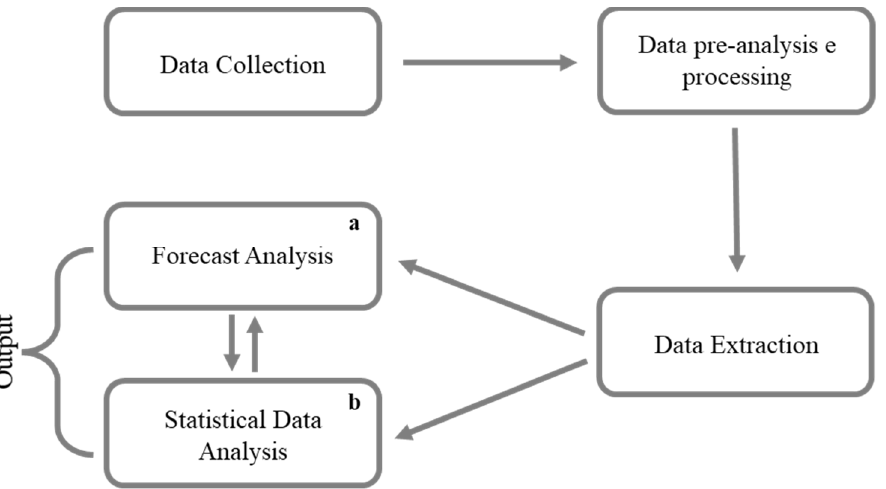
Figure A1. Block diagram of the machine-learning-based algorithm extraction for data mining for time series forecasting and statistical analysis. The current paper shows findings related to output box b.